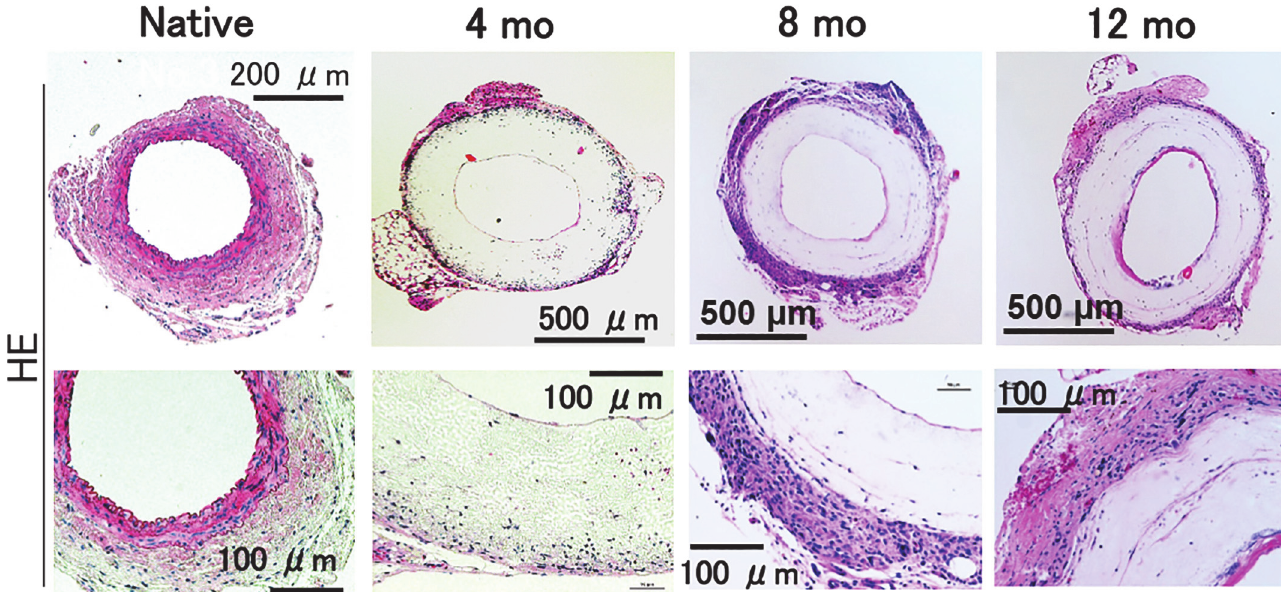
Fig 4. Histological assessment demonstrated active vessel remodeling and neo-vessel formation at 12 months after Implantation. Histologic analysis of TEVG was performed by Hematoxylin and Eosin staining at 5x (top) and 20x (bottom). At 4 months, there is a thin endothelium and some cellular infiltration at the periphery of the TEVG. By 8 months, tissue ingrowth at the periphery has increased. By 12 months, tissue ingrowth has increased at the luminal and peripheral surfaces, with increasing cellularity within the graft. (n = 5 in each group.)